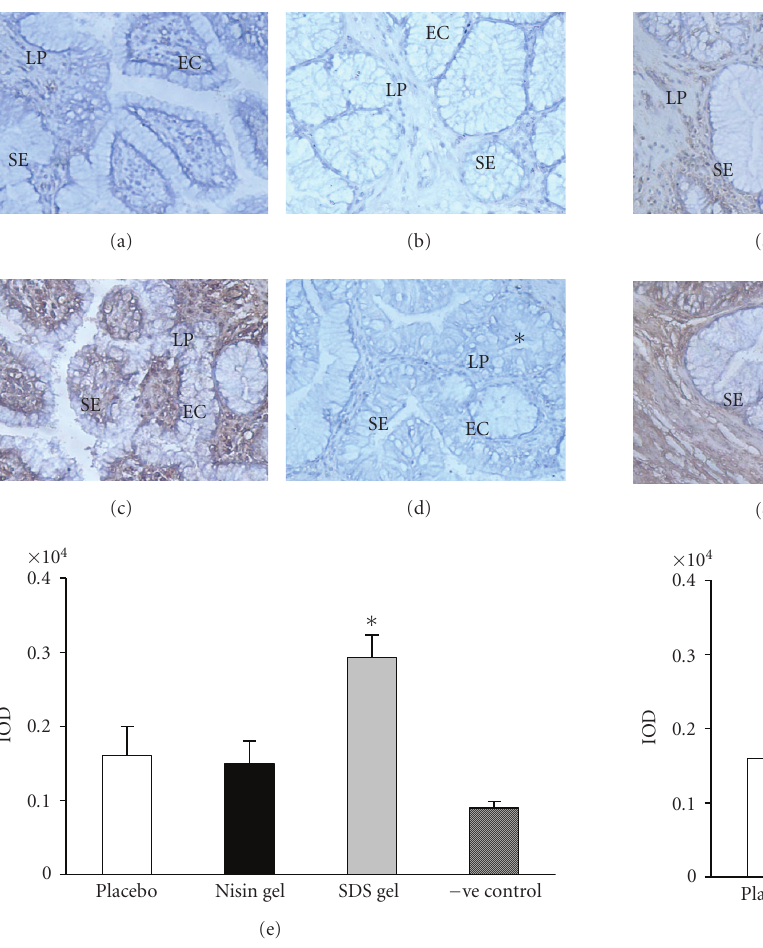
Figure 7: Immunohistochemical localization of TNF- α in the cer- vicovaginal tissue after intravaginal application of nisin (15.15mM in 2mL of 1% polycarbophil gel) (b), SDS (56 μ M in 2mL of 1% polycarbophil gel) (c) and 2 mL of 1% polycarbophil gel (a) for 14 consecutive days. To rule out the nonspecific binding, sections were incubated in preimmune sera instead of primary antibody and considered as negative control (d). Semiquantitative comparison by measuring integrated optical density (IOD) of immunoreactive TNF- α in treated and placebo is shown (e). The IOD in each area was then measured for the brown color immunoprecipitates. Each value is the mean ± SD of six observations obtained from three independent samples. Figure shown is representative picture from three independent experiments. (Mag X 20) (EC = epithelial cells, SE = squamous epithelium, LP = lamina propria) ( ∗ = values are statistically significant at P < 0 .